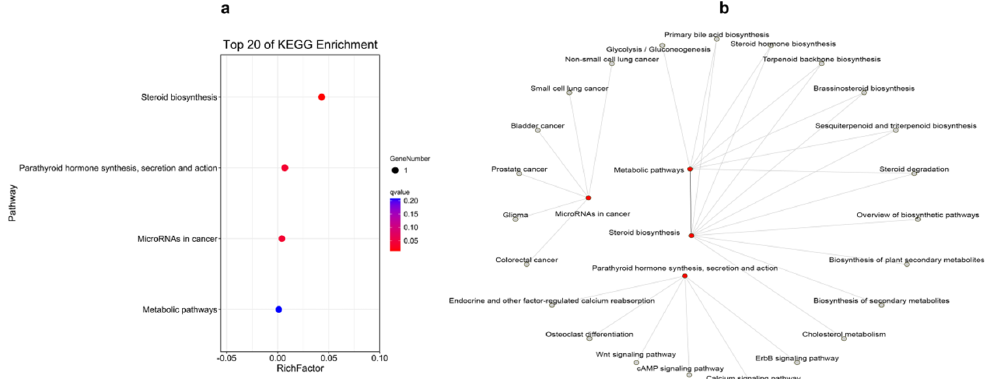
Figure 7. The Top 20 KEGG Pathways Enriched by the Differentially Expressed Genes of the Shared Genes at 12 h and 48 h Postinjection in the Liver, and the Network Graph among these Pathways: ( a ) the Pathway Enrichment of the Shared Differentially Expressed Genes; ( b ) the Network Graph among these Pathways.